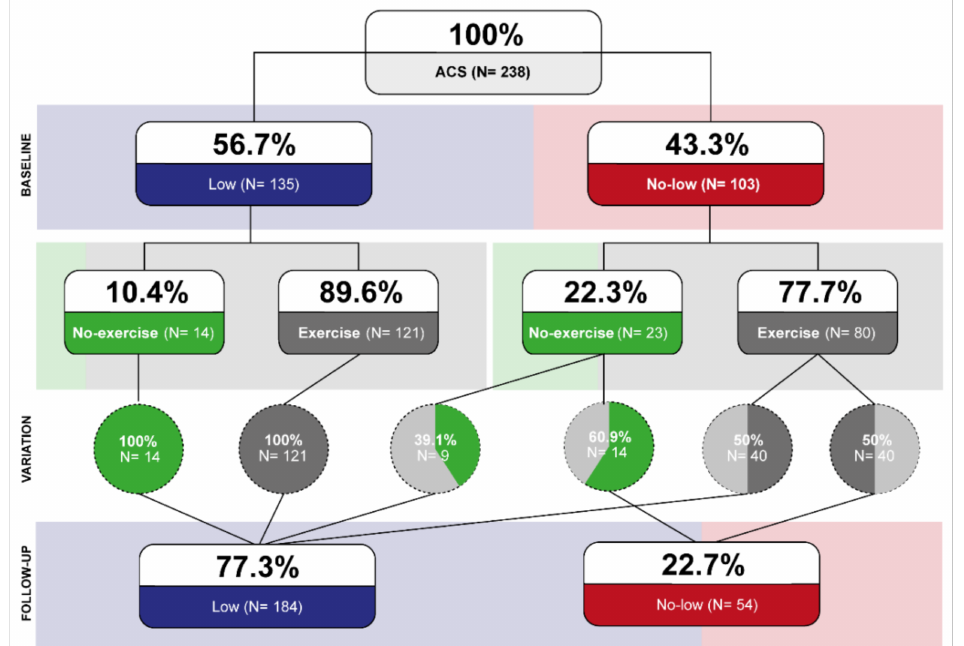
Figure 2. Risk stratification